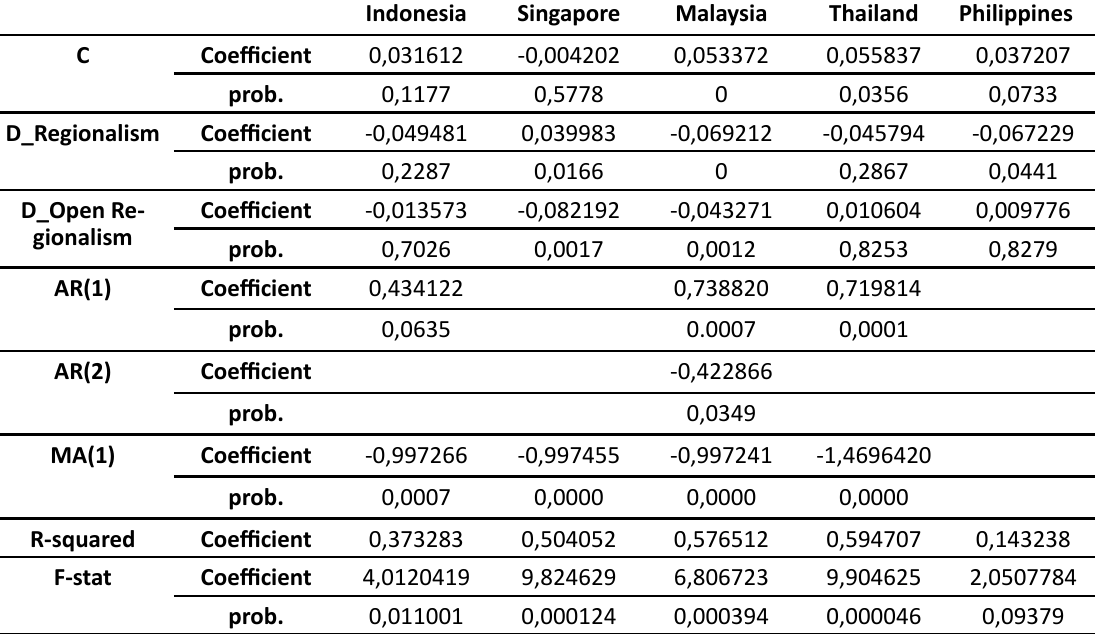
Table 2: Results of ARMAX Model Regression for ASEAN-5 Countries Exports Indonesia Singapore Malaysia Thailand